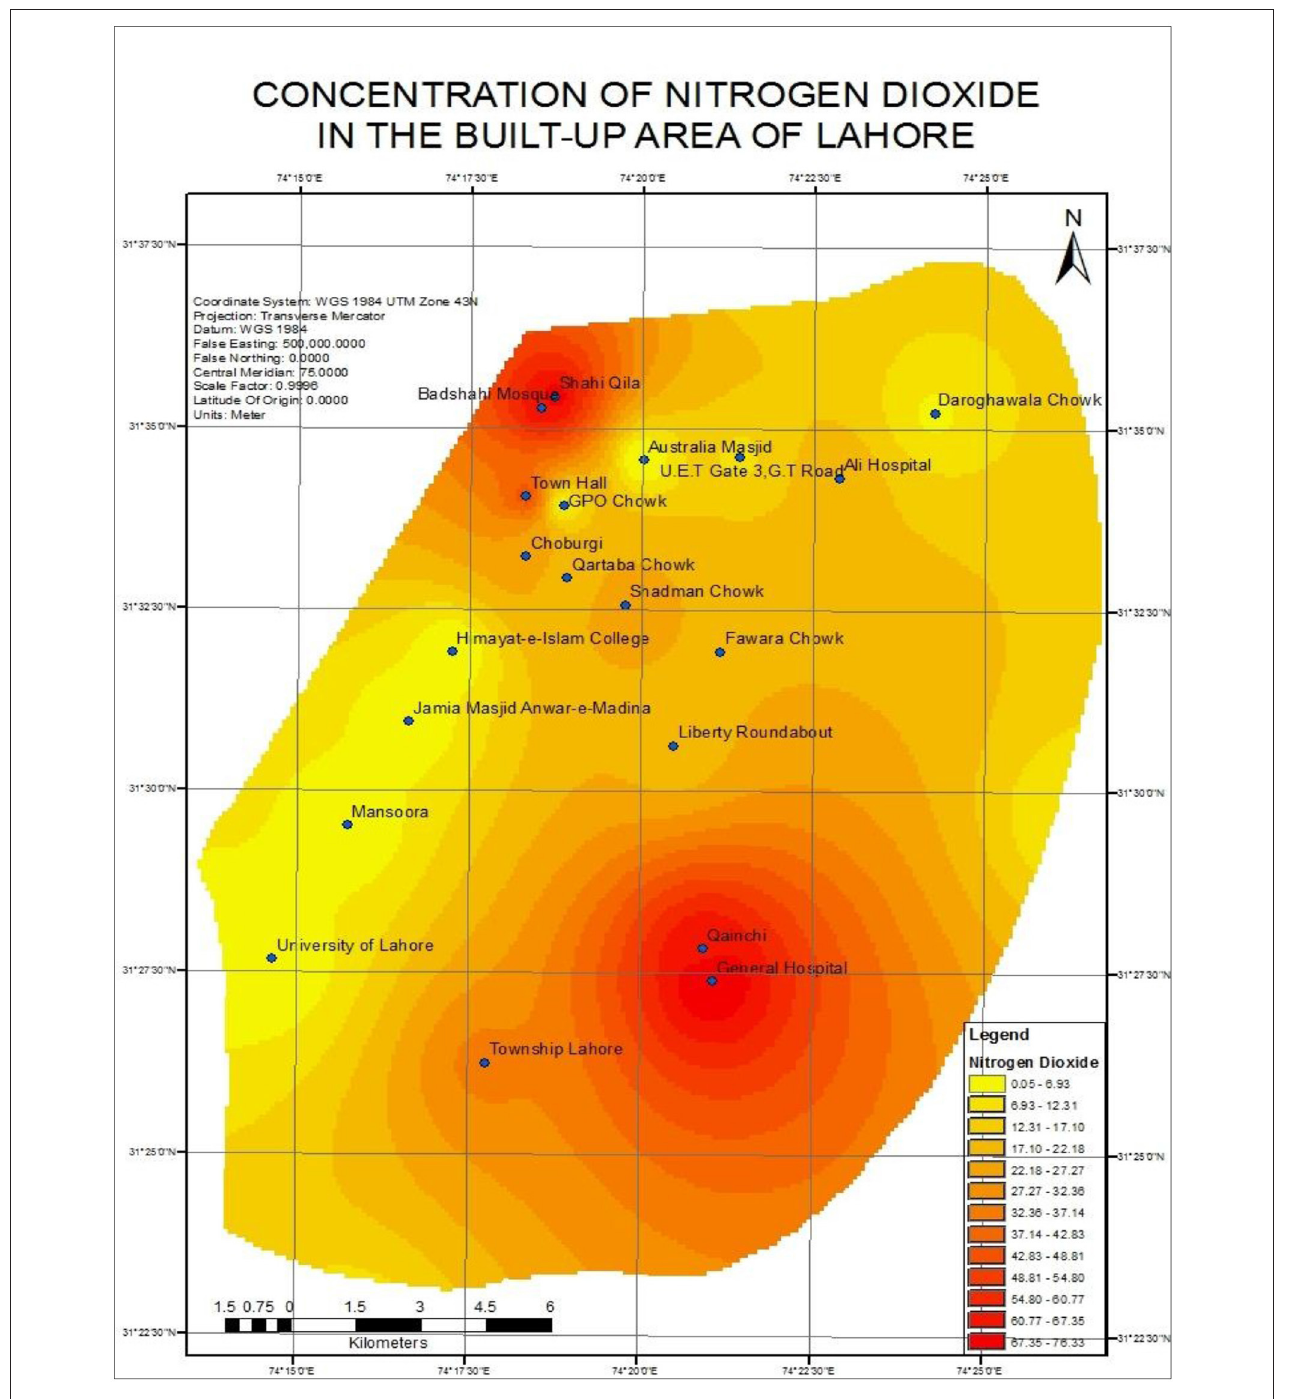
FIGURE 7 | Concentration of nitrogen dioxide.